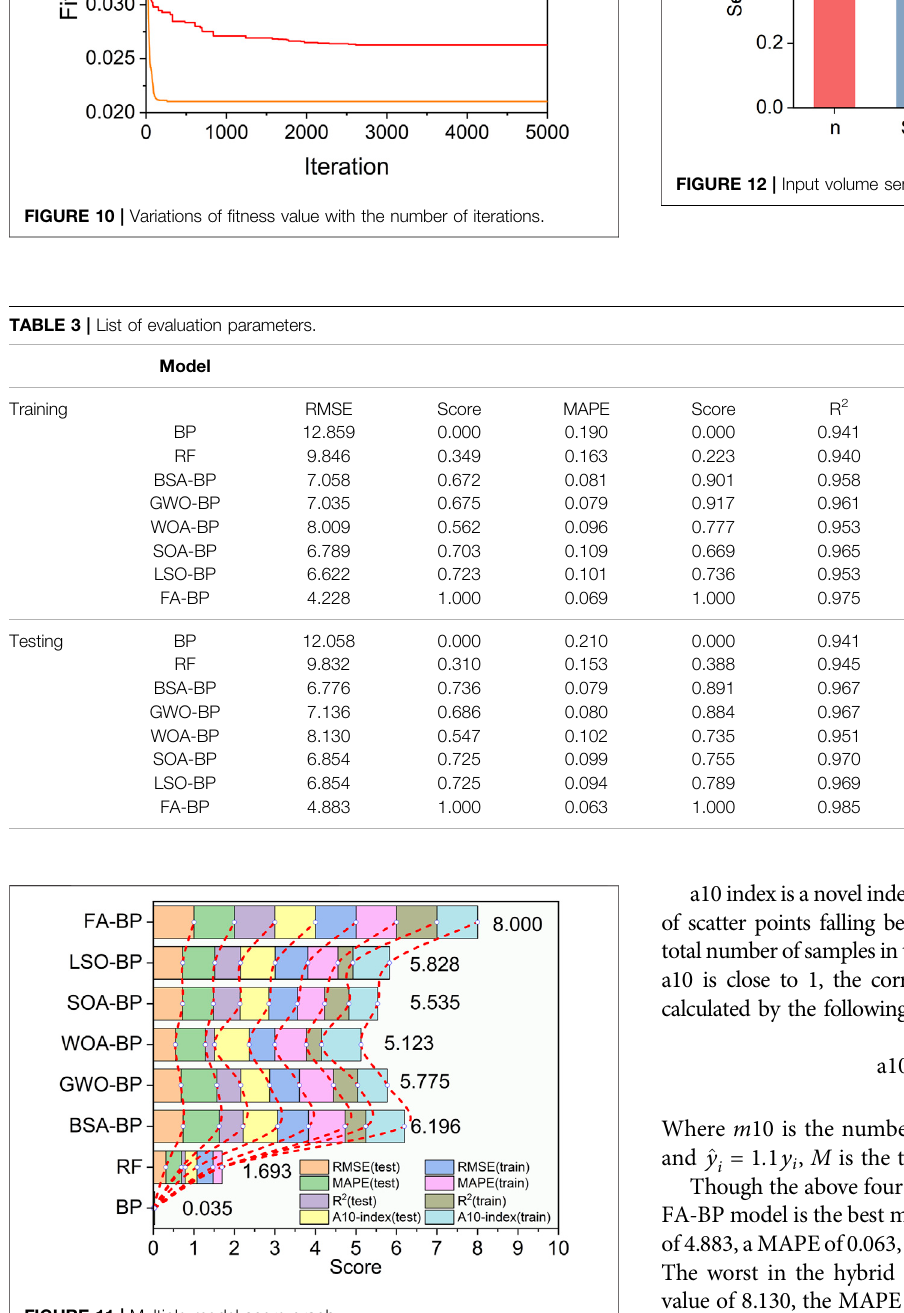
FIGURE 11 | Multiple model score graph.